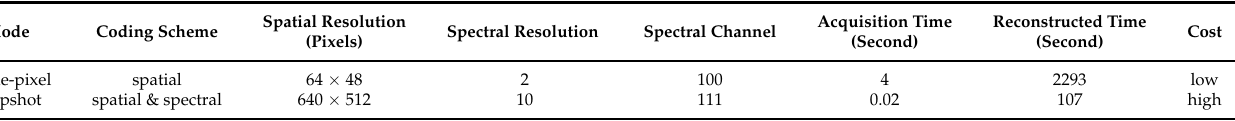
Table 5. The major differences between the two computational mid-wave infrared spectral imagers. Mode Coding